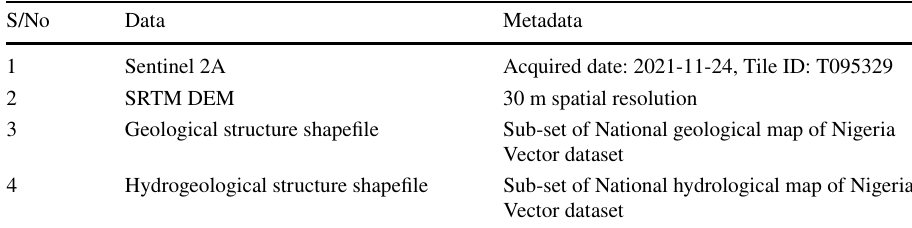
Table 1 Data used and their metadata